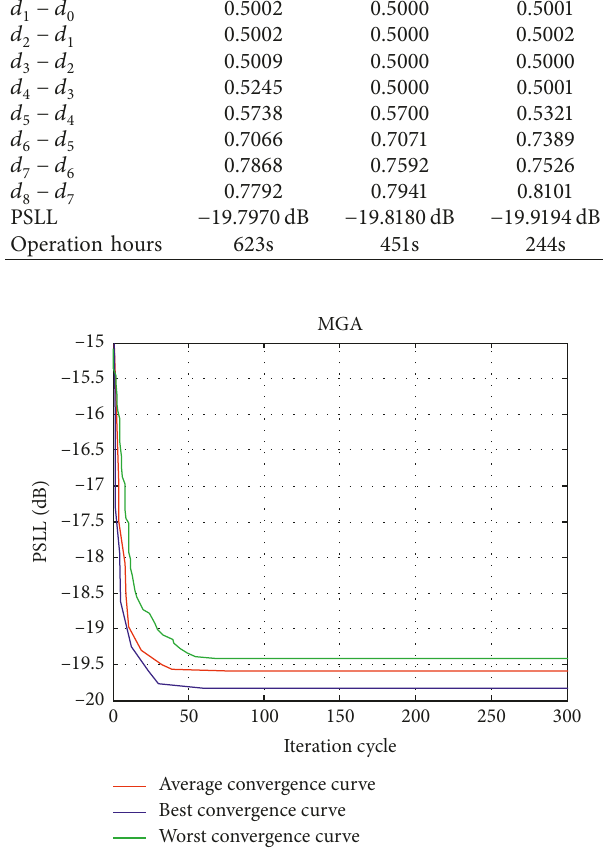
Figure 4: Convergence curve of fitness function. MGA for Example 1 optimization.